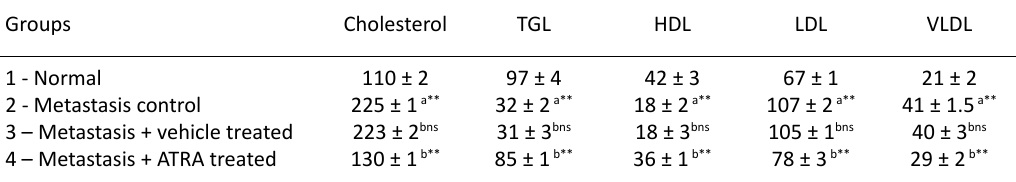
table 5. Lipid profile and cholesterol levels in the serum (mg/dl)